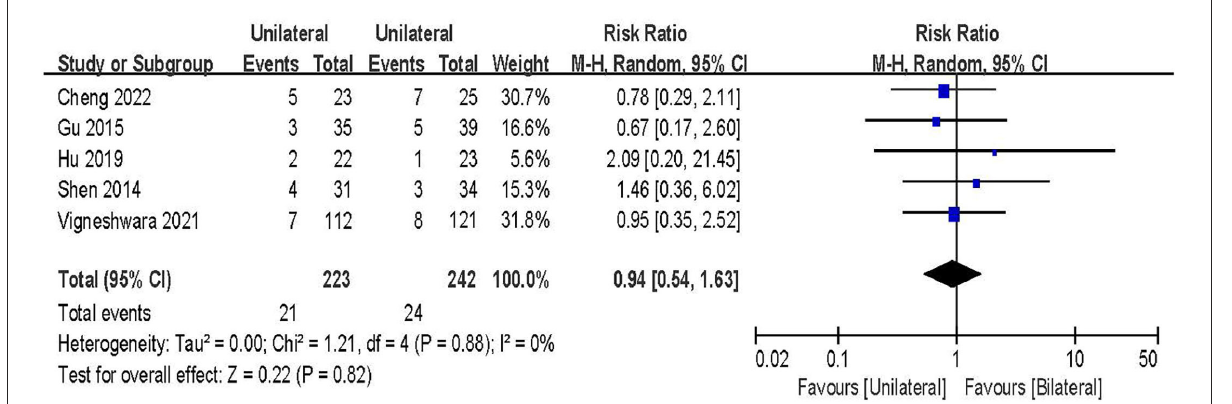
FIGURE10 Forest plot of complications rate.